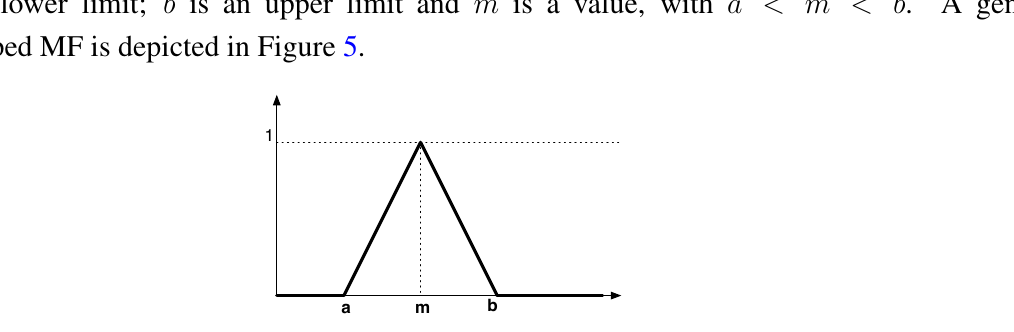
Figure 5. Generic triangular-shaped membership function.